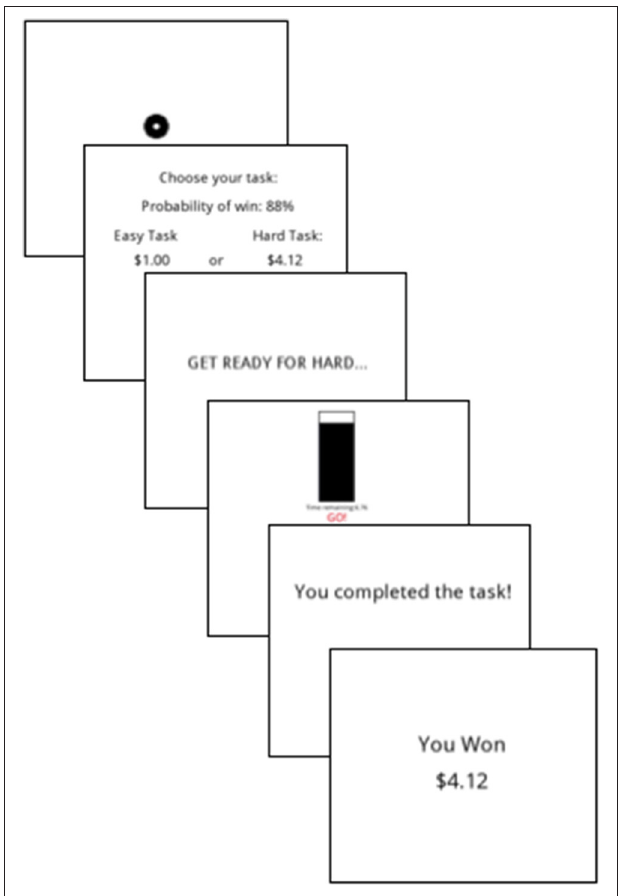
FIGURE 4 | Schematic depicting the trial sequence in the Effort Expenditure for Rewards Task [EEfRT; ( 24)]. In this example, the hard task was selected and successfully completed on a high reward magnitude and high probability trial.